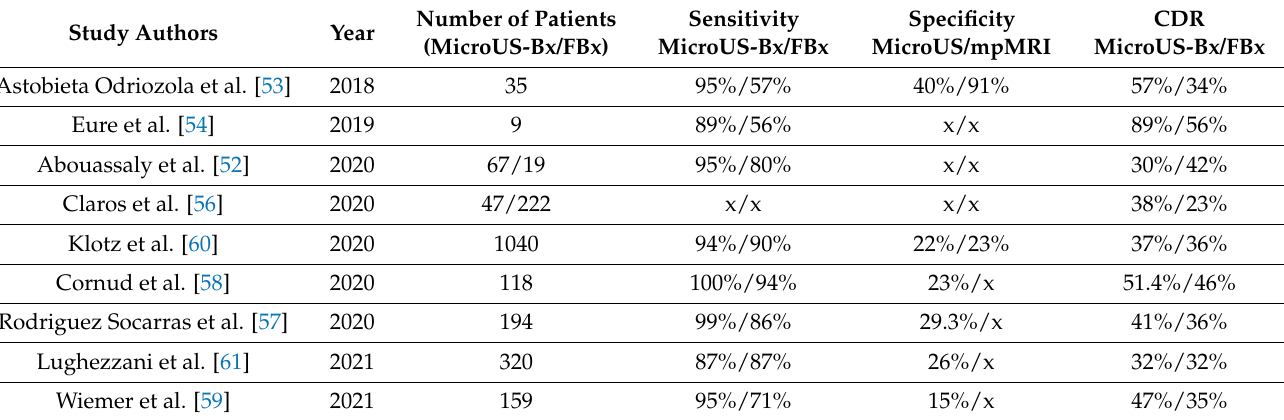
Table 3. Comparison of MicroUS-Bx and FBx performance in the detection of